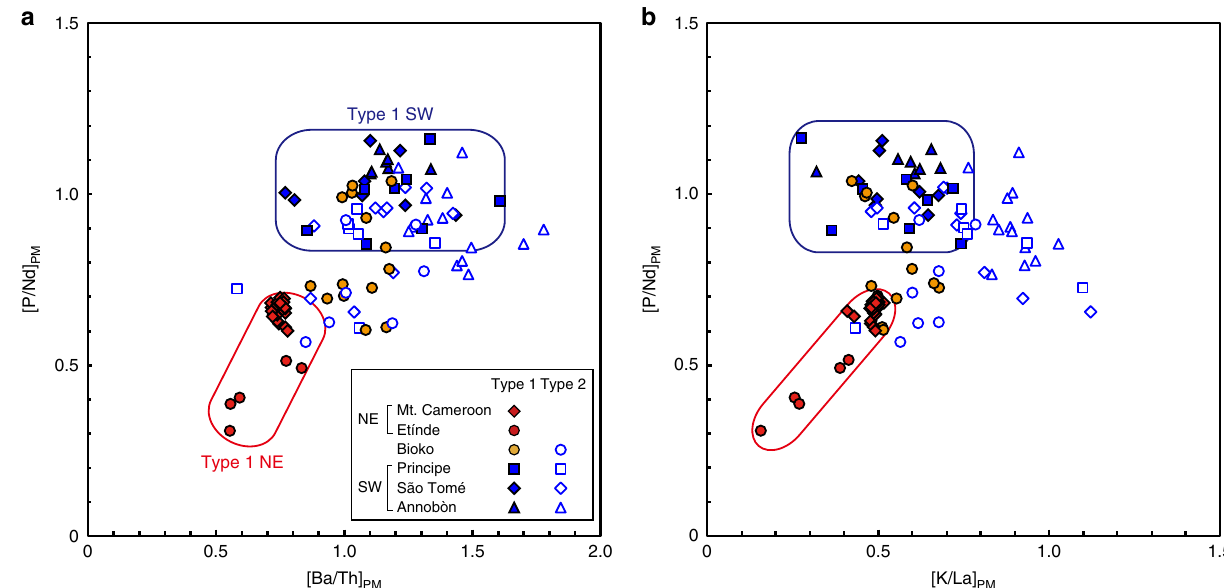
Fig. 4 Primitive mantle-normalized P/Nd, Ba/Th, and K/La variations of Cameroon volcanic line lavas. a [Ba/Th] PM vs. [P/Nd] PM and b [K/La] PM vs. [P/ Nd] PM . Primitive mantle normalizing values are after ref.